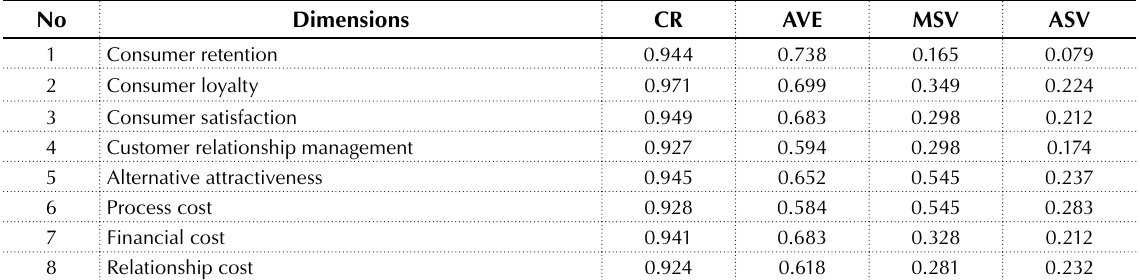
Table 2. Convergent and discriminate